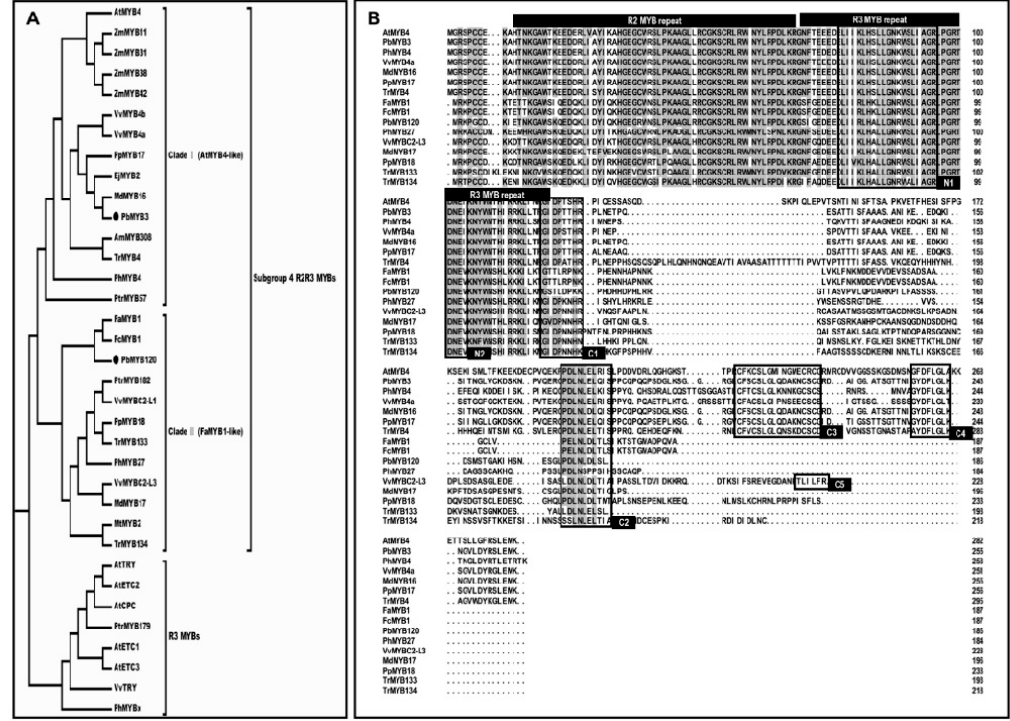
Figure 1. Characterization of PbMYB120. ( A ) Phylogenetic analyses of the subgroup 4 R2R3 MYBs. The subgroup 4 R2R3 MYBs were classified into two subclades: Clade Ⅰ (AtMYB4-like) and Clade Ⅱ (FaMYB1-like). R3 MYBs were added as the out-group. PbMYB3 and PbMYB120 are marked with solid circles. Protein sequences of the subgroup 4 R2R3 MYBs and R3 MYBs used were obtained from the NCBI database. Protein accessions are listed in the “Materials and Methods”. ( B ) Amino acid sequence alignment of typical subgroup 4 R2R3s and the identification of conserved domain motifs.